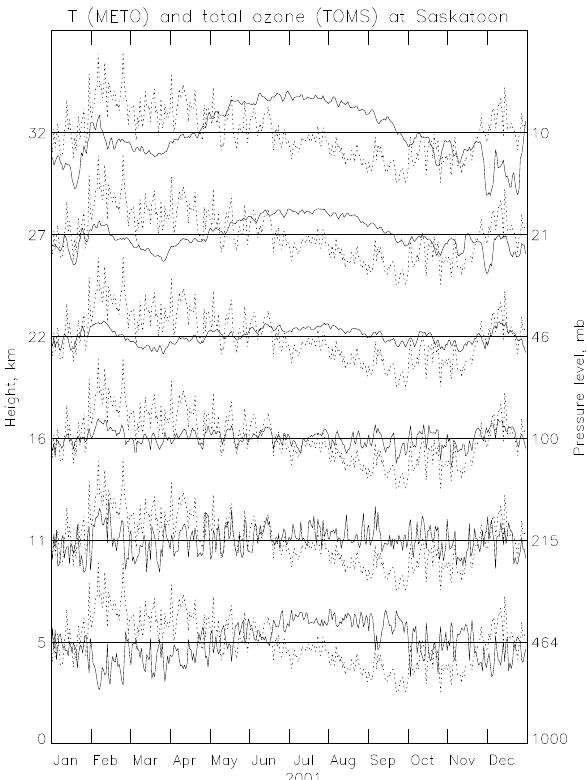
Fig. 1. The variations of total ozone (dashed line) and MetO temper- atures (solid lines) at several heights/pressure levels for Saskatoon, 2001. For convenient comparison the variations of total ozone are shown for each height/pressure level. Different scales have been used to plot ozone (200 DU per division) and temperature (40K per division) variations to make them